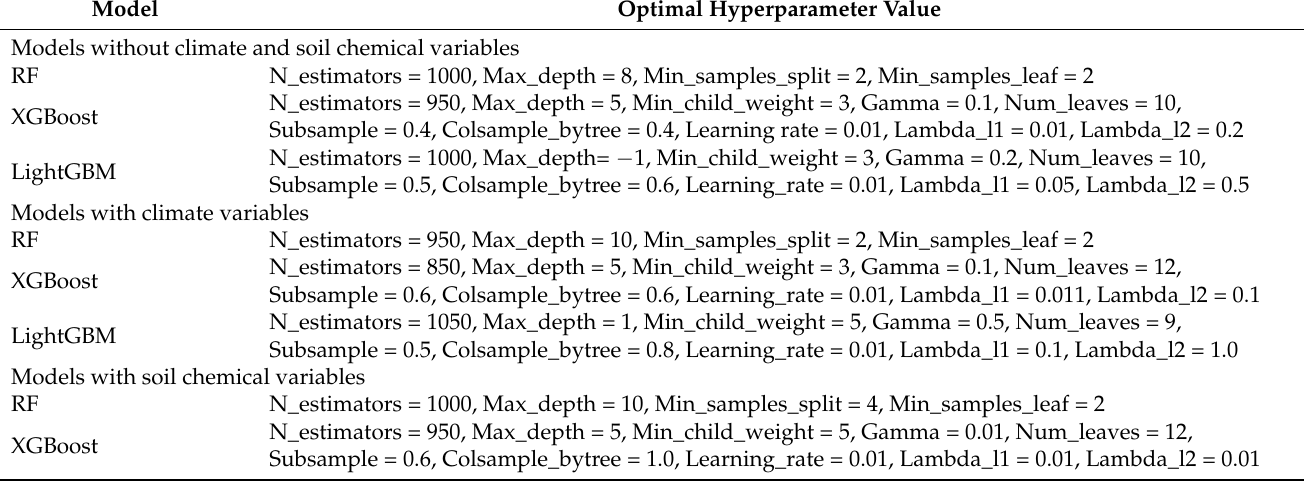
Table 3. Optimal hyperparameters for the machine learning models (RF, XGBoost, LightGBM) with different variable